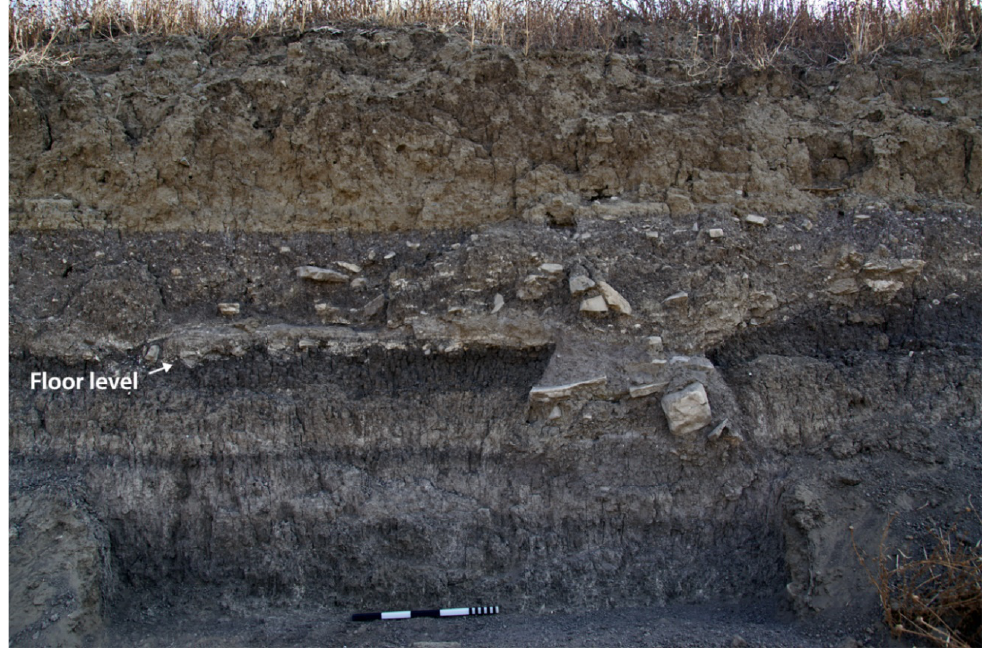
Figure 6. The remains of a Middle Chalcolithic floor, most probably belonging to a Chalcholithic house (Image by Charalambos Paraskeva).